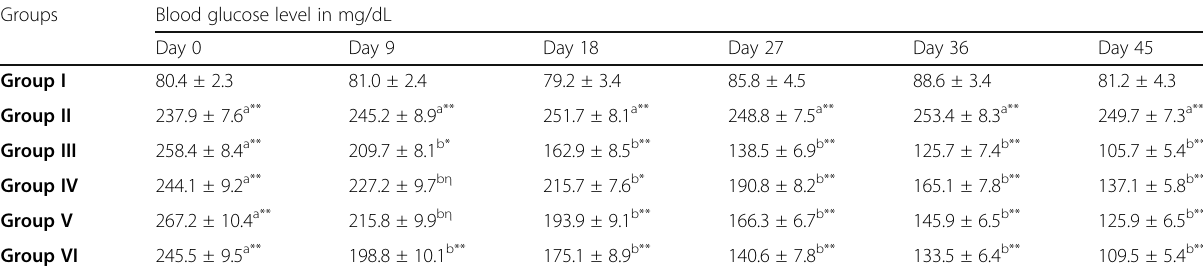
Table 2 Effect of CRME on blood glucose level